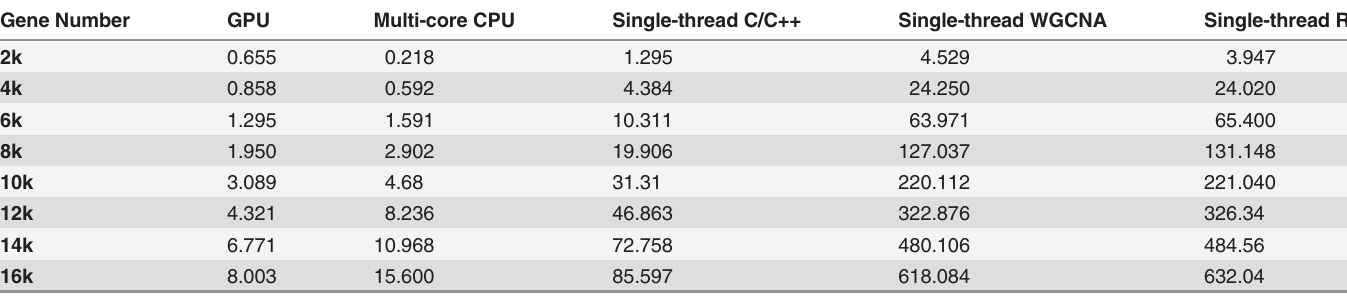
Table 2. Running time (in seconds) for the GPU implementation, Multi-core CPU implementation, Single-thread C/C++ implementation and Single-thread R implementation when no genes were fi ltered out during data preprocessing stage (individual number = 590). Gene